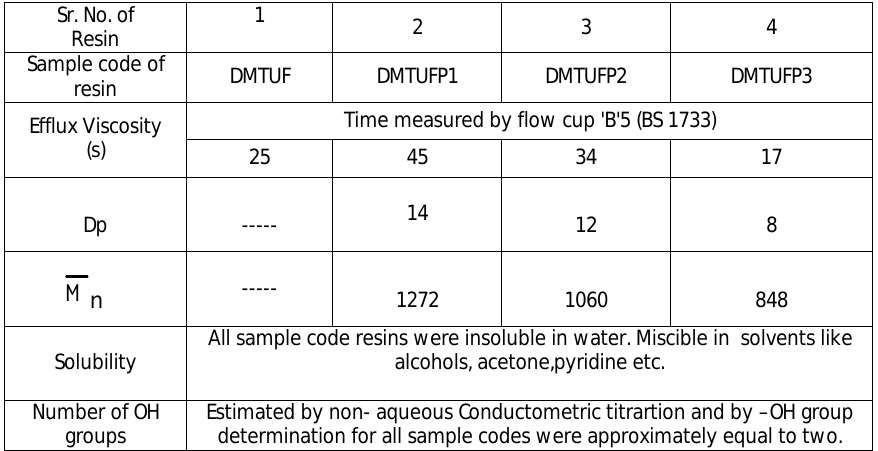
Table 2Table 2 Physical parameters of Dimethylol thiourea-formaldehyde and Dimethylol thiourea- formal dehyde-phenol resin Sr. No. of Resin